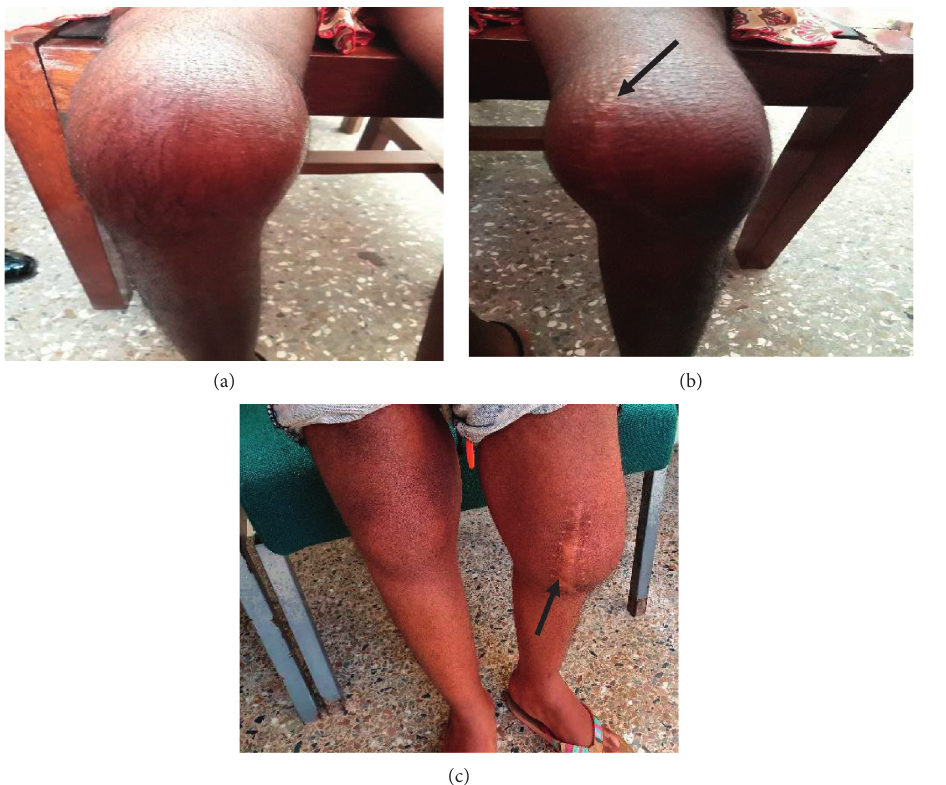
Figure 2: (a, b) Synovitis of the right and left knees when the patient was first seen at the outpatients’ department. (c) A significant decrease in knee synovitis 2 months into treatment, with an old arthrotomy scar